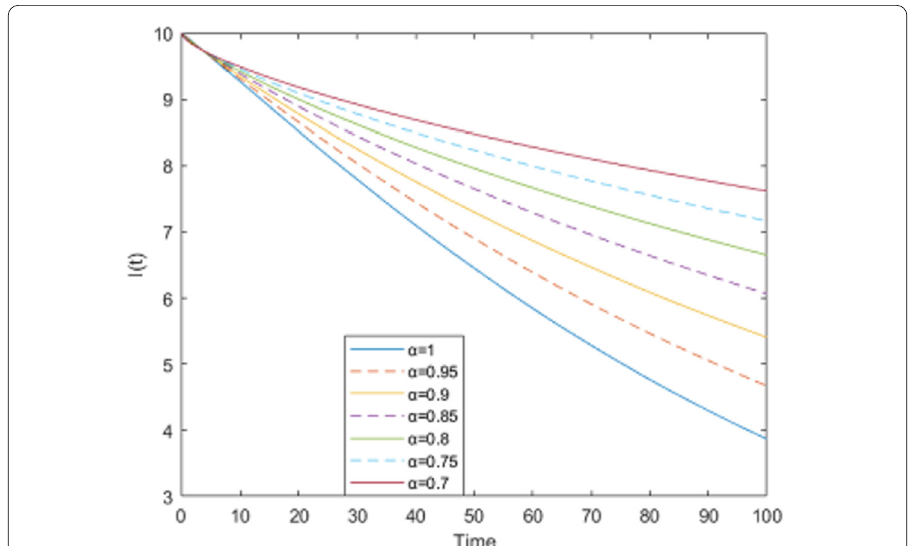
Figure 9 The class of researchers affected by criticisms